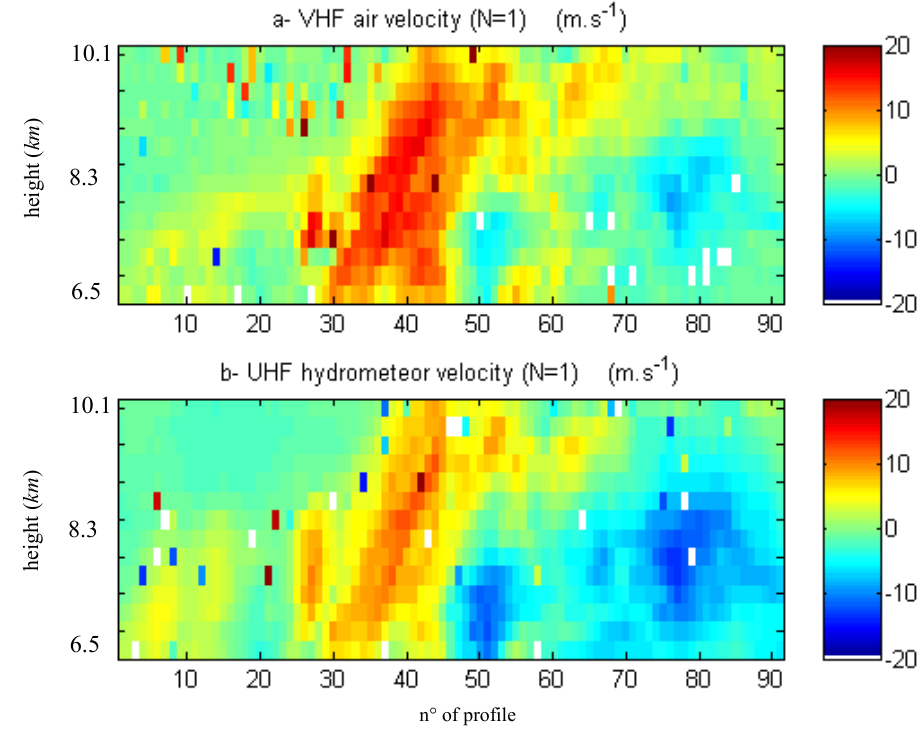
Fig. 4. Doppler radial velocity of hydrometeor (UHF) and air (VHF), assuming N = 1 echo.